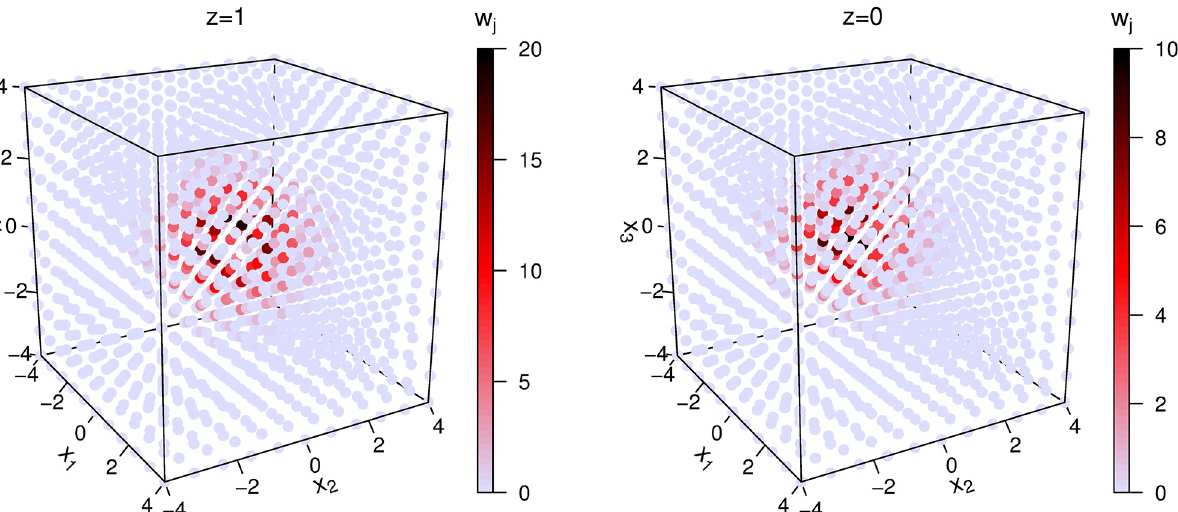
(left column) and plot of sorted w j